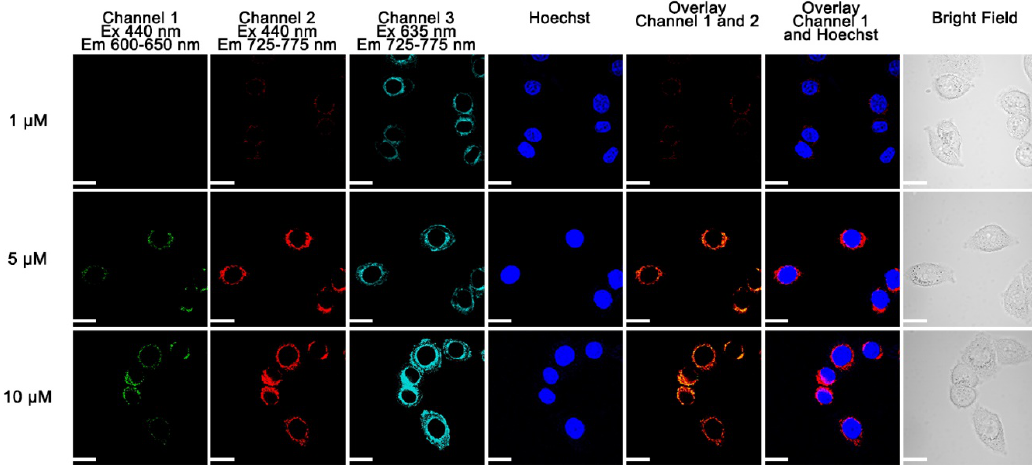
Figure 10. Live-cell fluorescence images of HeLa cells incubated with probe B + for 2 h and then with Hoechst stain for 1 h with scale bars at 20 µm. The excitation of Hoechst is 405 nm and the fluorescence collect window is from 425 to 475 nm.